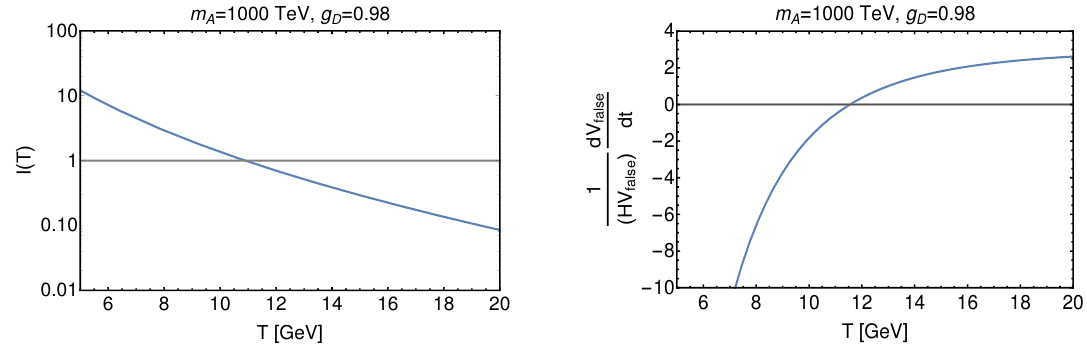
Figure 12 . Left: an example calculation for the phase transition in the classically scale invariant case. Here the percolation condition is achieved at T p ’ 10 : 5 GeV. Right: the physical volume of false vacuum is rapidly diminished at and below T p ’ 10 : 5